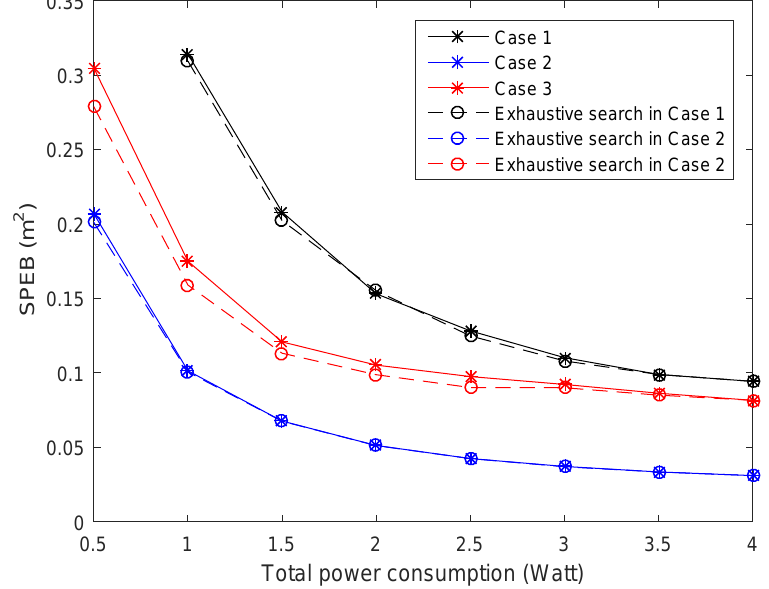
Figure 7. The SPEB of service area with respect to the total power consumption by proposed algorithm and the exhaustive search method in different